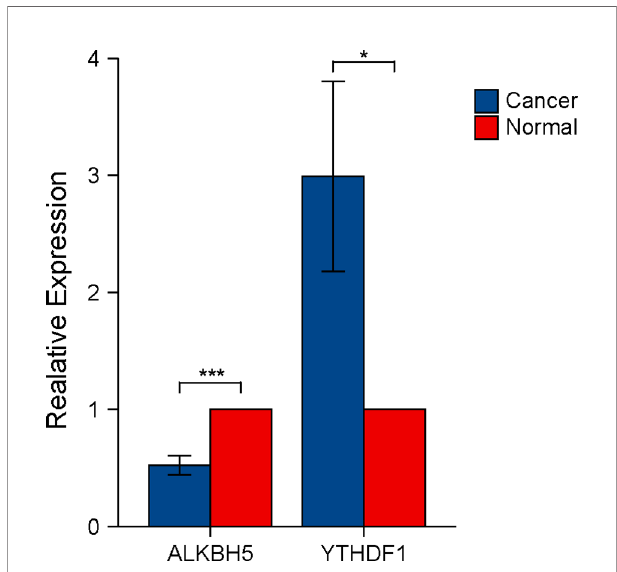
FIGURE 8 | Veri fi cation of ALKBH5 and YTHDF1 expression in CRC tissues using RT-qPCR. The P values are labeled using asterisks (ns, no signi fi cance, *P < 0.05, ***P <